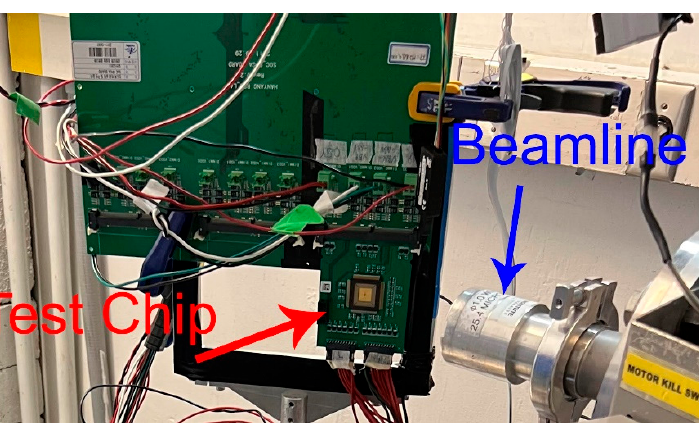
Figure 8. Heavy ion experimental setup at the TAMU Texas A&M University. The incident angle was set at 60° from normal.